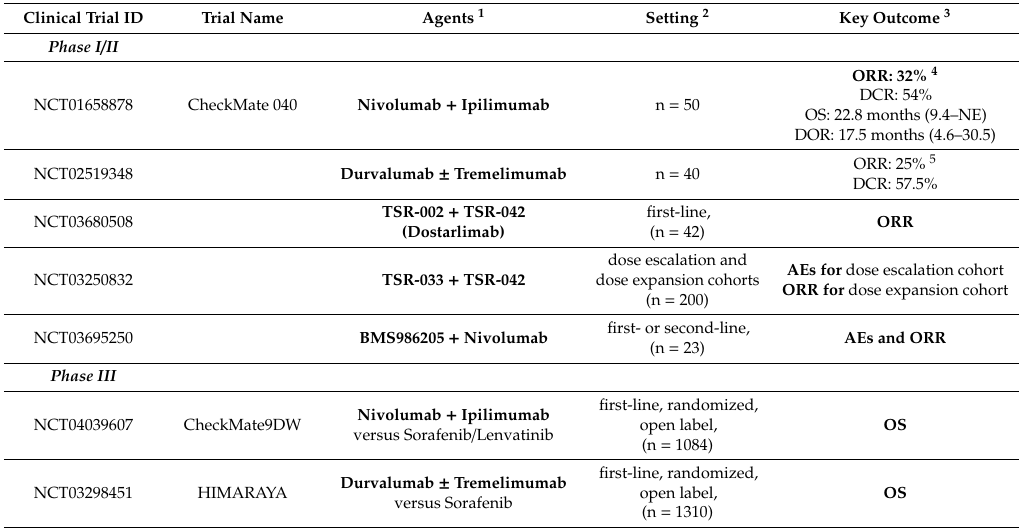
Table 2. Clinical trials and outcomes of combined immune checkpoint blockade in